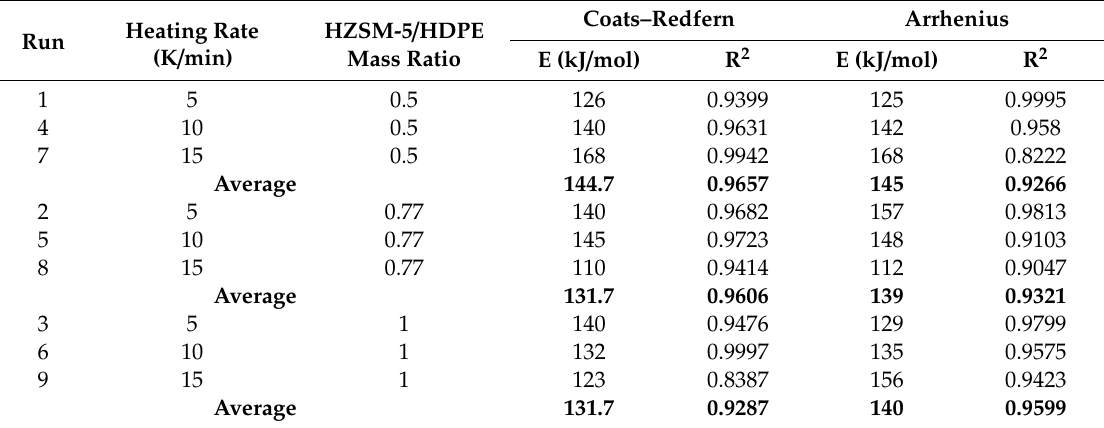
Table 7. Activation energies calculated by non-isoconversional